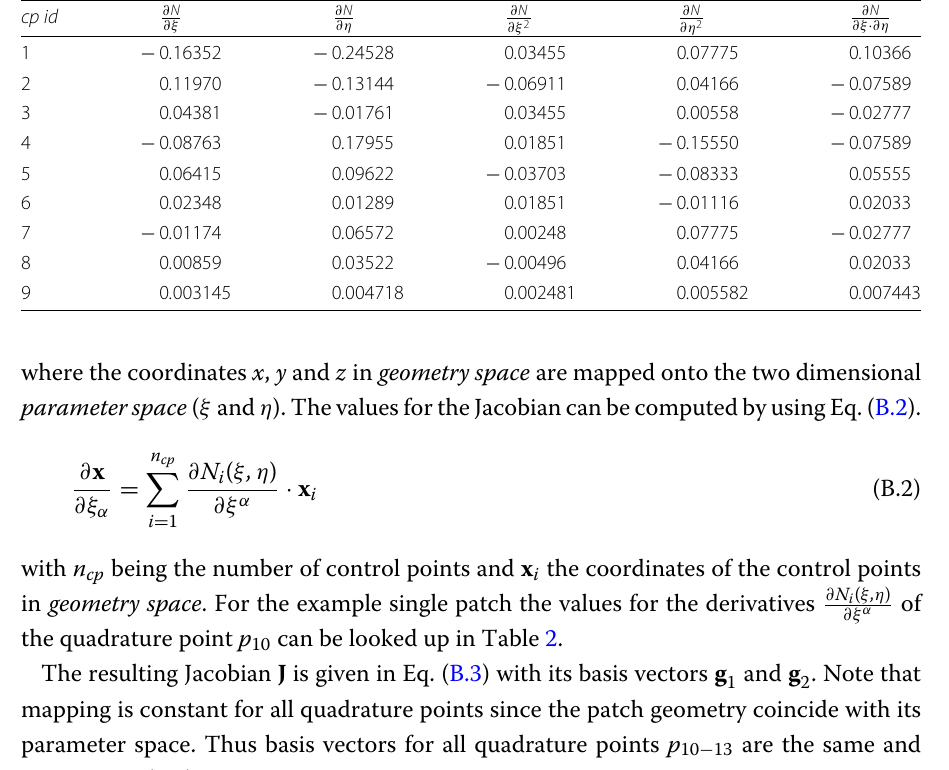
Table 2 Example single patch: first and second order derivatives of the shape functions N i ( ξ , η ) evaluated on the quadrature point p 10 (see Fig. 21) with the parameters ξ = 1 . 2679 and η = 0 . 8452 (see Listing